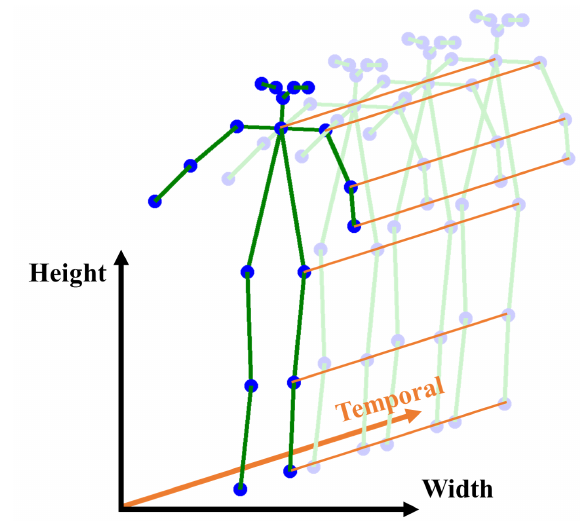
Figure 3. Model structure of stacked hourglass model